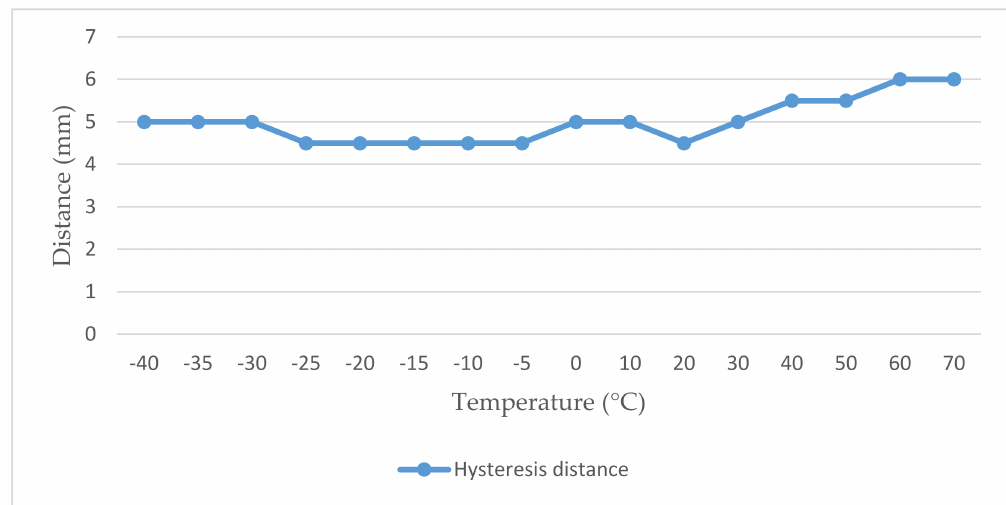
Figure 8. Graphical representation of the values of the hysteresis phenomenon of the magnetic contact USP 131.